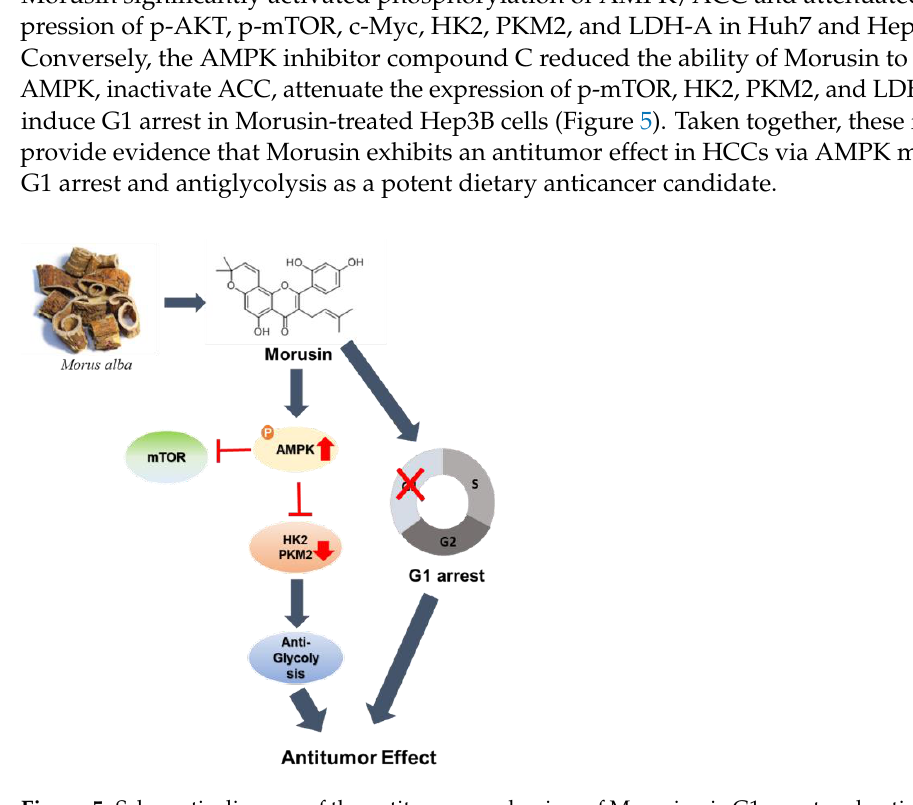
Figure 5. Schematic diagram of the antitumor mechanism of Morusin via G1 arrest and antiglycolysis by AMPK